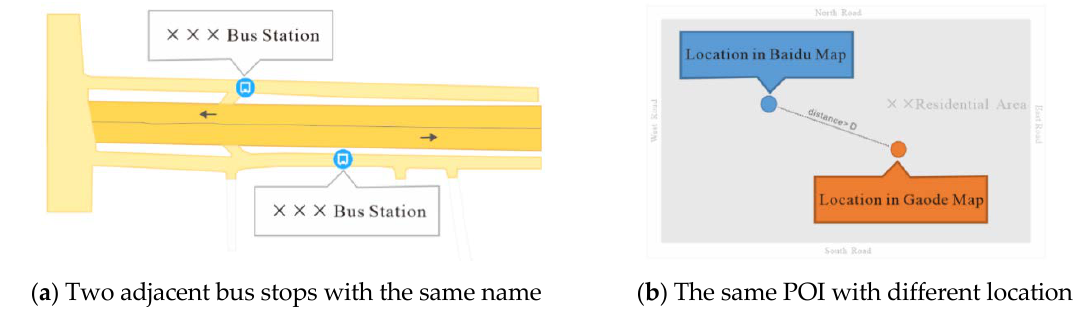
Figure 3. Incorrect and missed matching only considering the spatial distance.